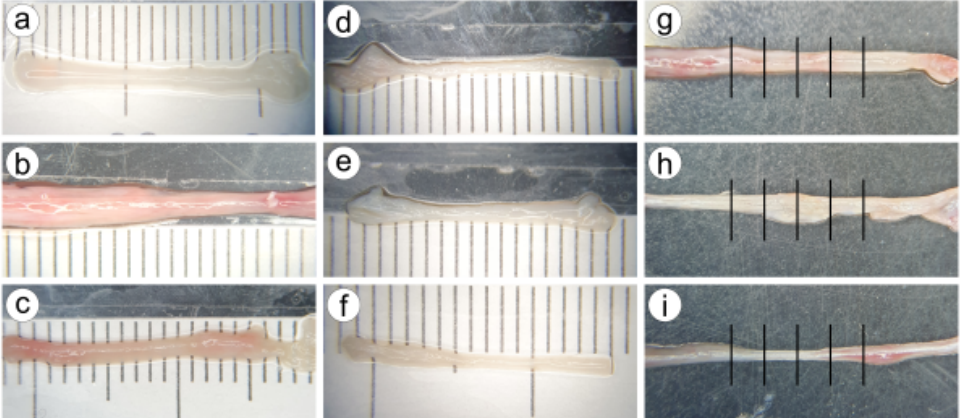
Figure 1. Nine images of different CBV specimens captured with the camera coupled to the micro- scope ( a – i ). The diameter and width vary slightly along the CBV. Subfigures ( g – i ) show the five measures of the apparent width in the central region. This was repeated for all CBVs, so the outer diameter OD was computed from measures of the